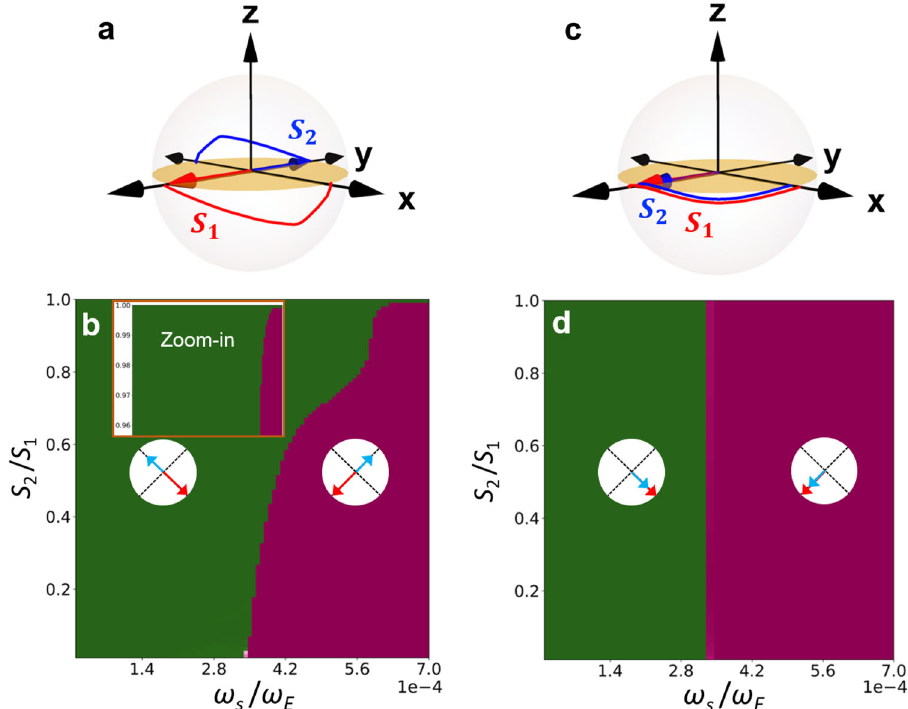
Fig. 5 Trajectory and dynamical phase diagrams for SOT-induced switching. a , c Trajectories of antiparallel and parallel spins with S 2 = S 1 ¼ 0 : 9 and other parameters explained in “ Methods ” . b , d Dynamical phase diagrams in terms of the terminal state of the order parameter [Néel vector n in ( b ) and magnetic vector m in ( d )] plotted for S 2 = S 1 2 ½ 0 ; 1 (cid:5) with S 1 þ S 2 ¼ 2. The unswitched and switched regions are marked by different colors and illustrated by the